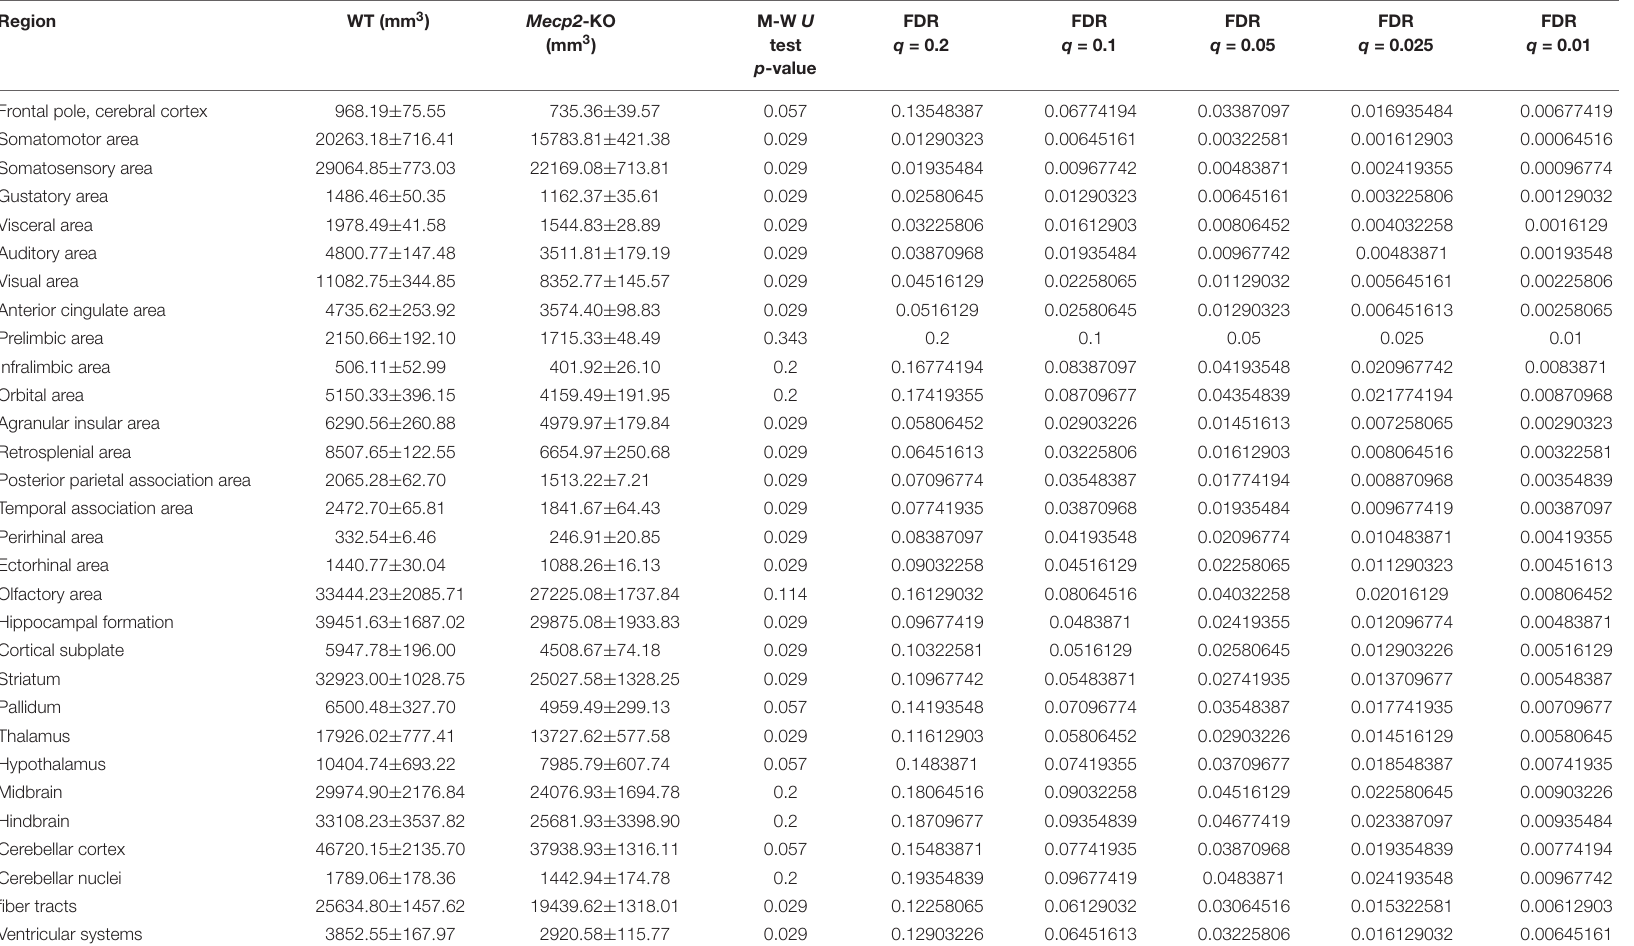
TABLE 3 | Calculated regional brain volume (processing pipeline 1; Mann Whitney U test, FDR adjustment).